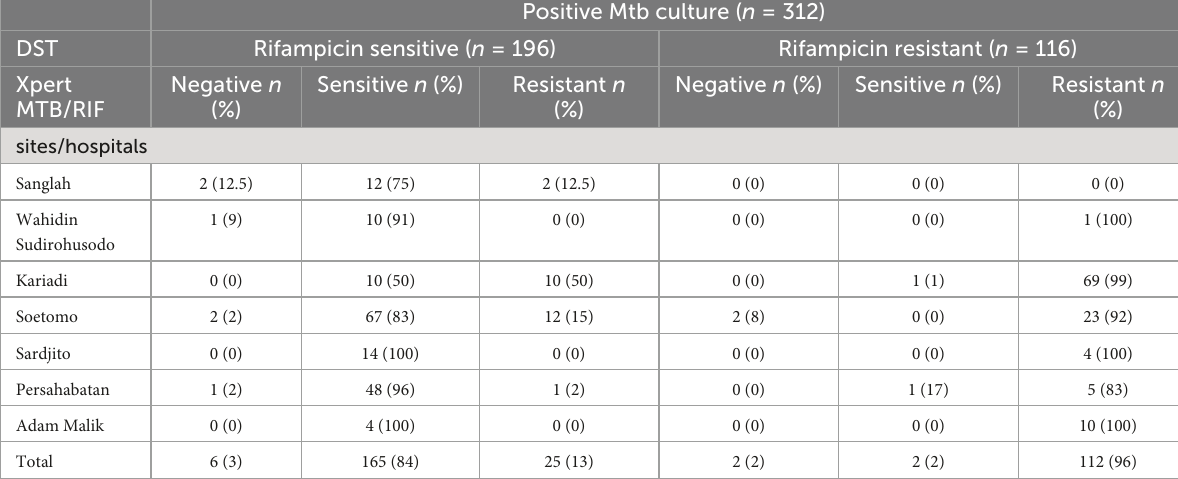
TABLE 4 Performance of Xpert MTB/RIF vs. DST for rifampicin susceptibility testing by